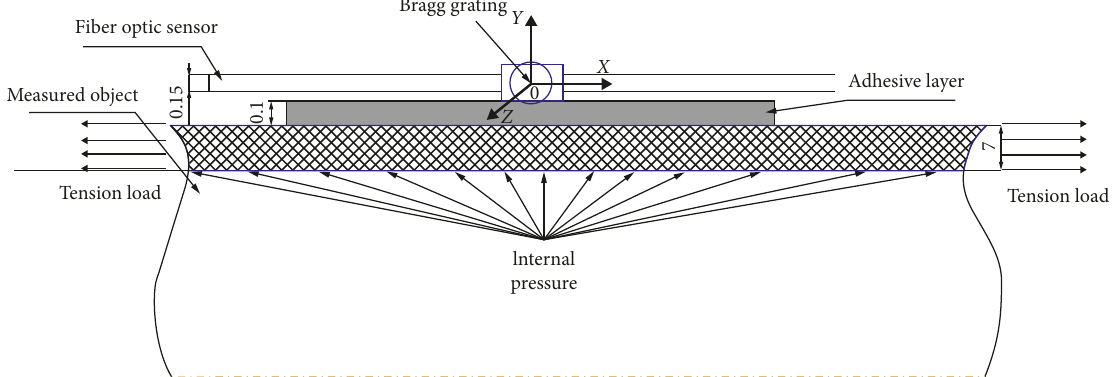
Figure 1: Model scheme for calculation of strains transferred from the measured surface through the adhesive layer to FBG.